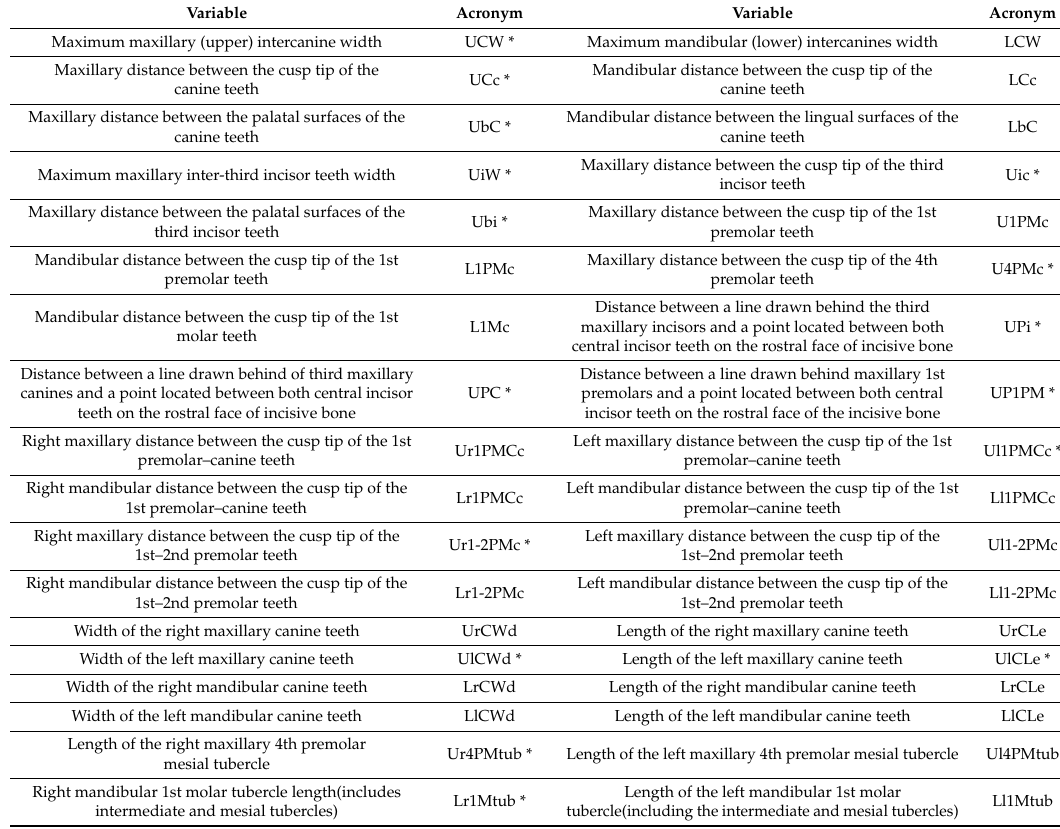
Figure 1. The studied measurements. ( A ) The canine and incisor measurements on the maxillary and incisive bone. The same canine measurements were taken from mandibular canines; ( B ) Measurements were taken on the maxillary dental arch between one tooth and its counterpart on the opposite side, and some were also taken on the mandible; ( C ) Distance from a line drawn behind the three teeth (third maxillary incisors, canines and first premolars) and a point located between both the central incisor teeth on the rostral face of the incisive bone (black circle); ( D ) ULCLe, also registering the same measurement on the right side and for the mandibular canines, (PM1: first premolar); ( E ) Lr1Mtub and the same measurement taken on the left side, (PM4: fourth premolar, M1: first molar); ( F ) Ur4PMtub and the same measurement taken on the left side. Table 1. Acronyms of the studied